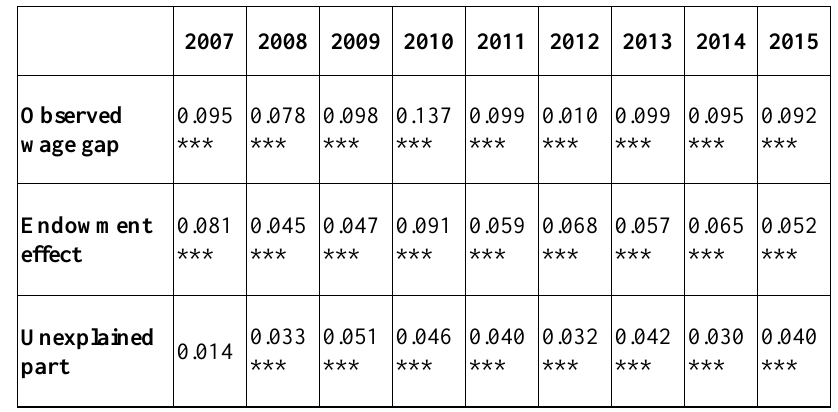
Table A1. Decomposition of the Ethnic Wage Gap (log points;